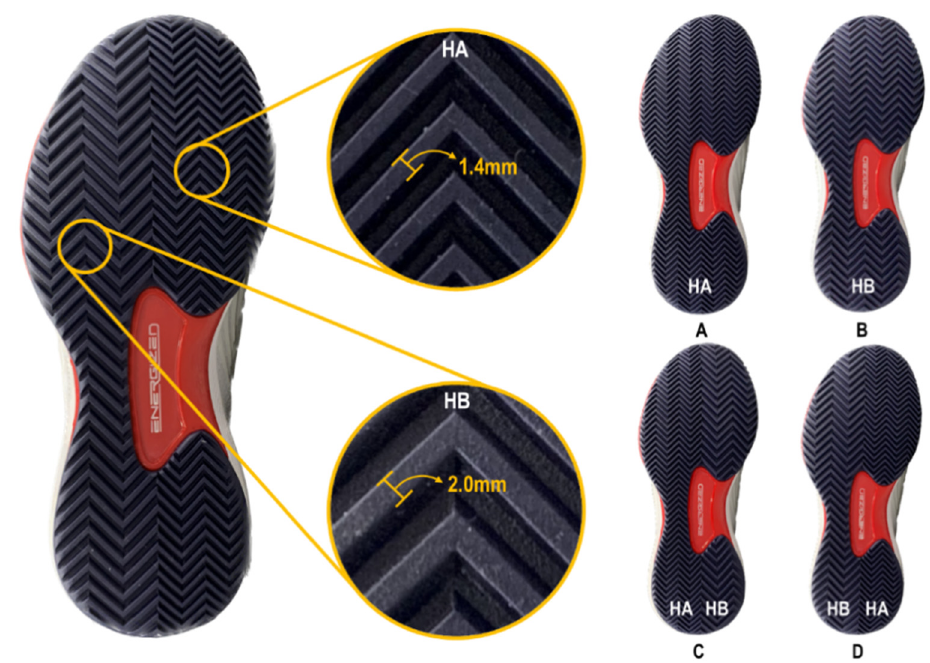
Figure 1. Different widths of outsole pattern and tennis shoes ( A – D ).